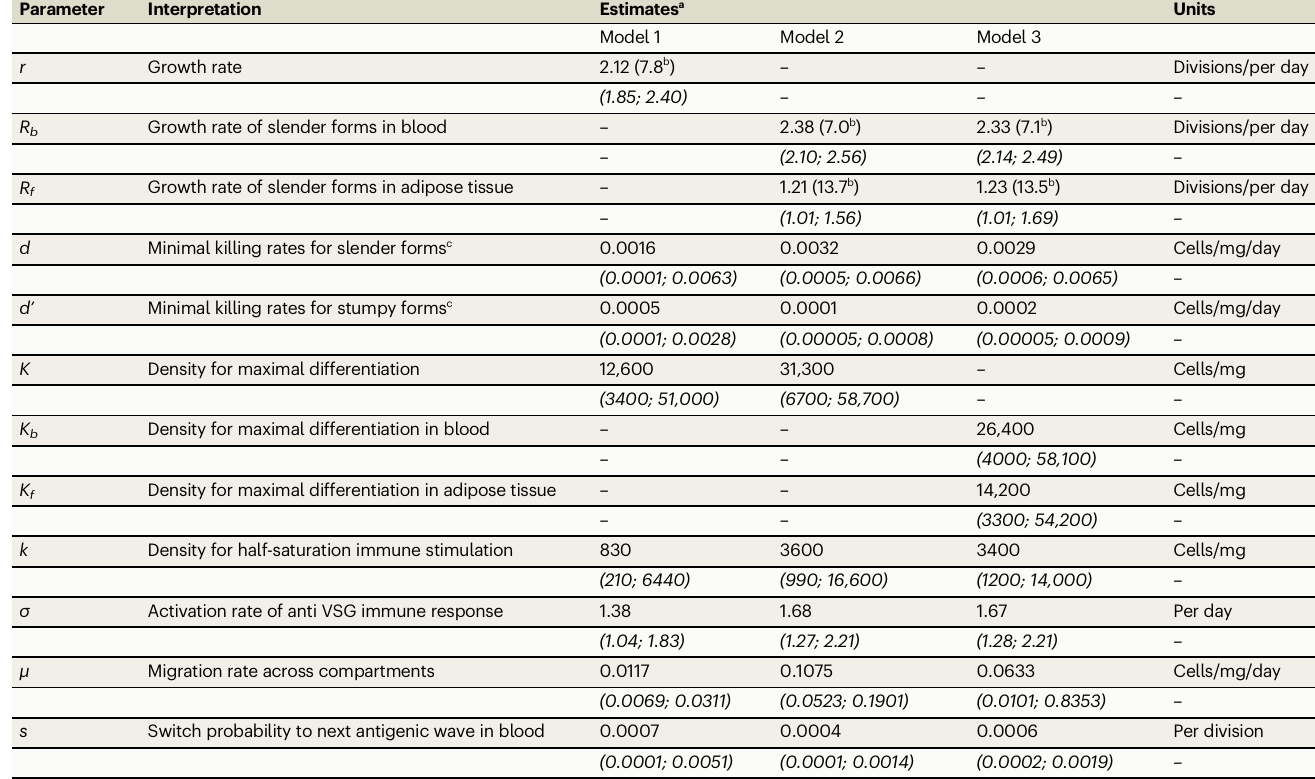
Table 1 | Mathematical models parameters and